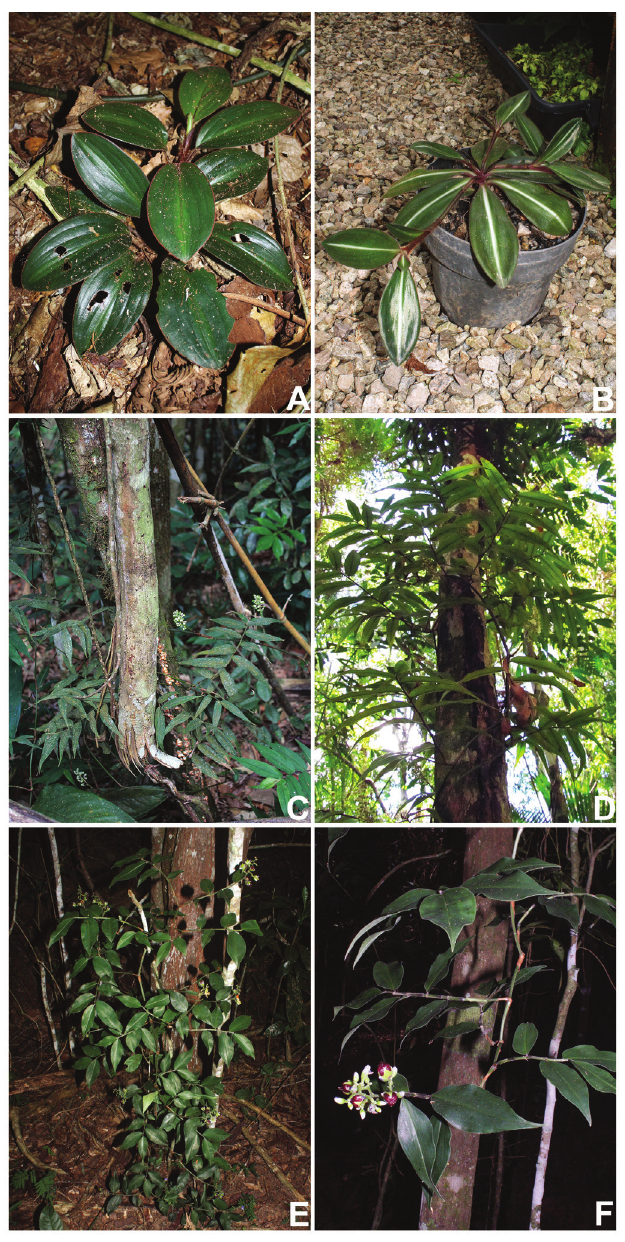
Figure 3. Growth forms in Dichorisandrinae s.s . A – D Siderasis Raf. emend. M.Pell. & Faden: A rosette habit of S. fuscata (Lodd.) H.E.Moore B rosette habit with flagelliform-shoots of S. albofasciata M.Pell. C habit of an immature, still prostrate, individual of S. zorzanellii M.Pell. & Faden. D habit of a mature individual of S. zorzanellii spirally ascending a tree. E – F Dichorisandra hexandra (Aubl.) C.B.Clarke: E intertwined habit F decumbent stem apex, bearing flowers and fruits. Photographs A–B, E–F by M.O.O. Pellegrini, C–D by J.P.F.